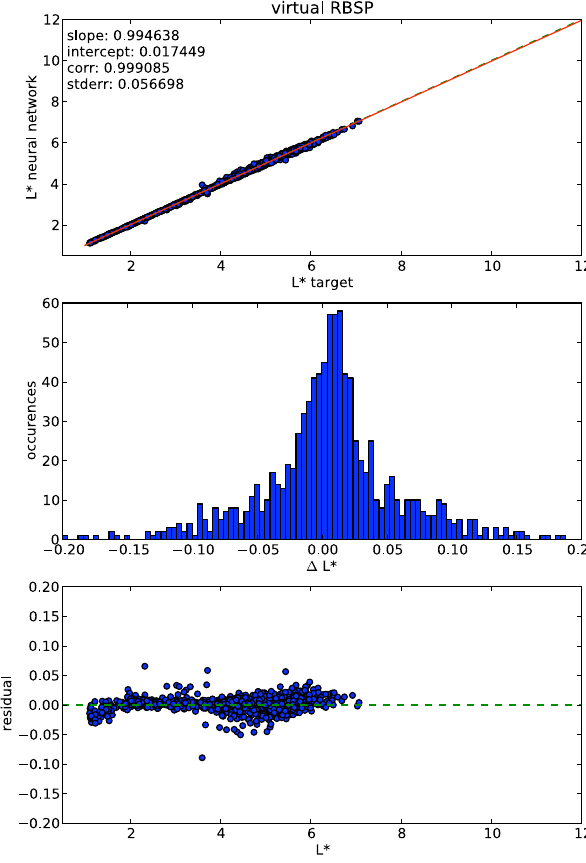
Fig. 4. Validation of neural network with Polar satellite ephemerides. Top: scatter plot of L ∗ values from TS05 model (tar- get) against neural network results. Green-dashed line indicates a perfect fit and red solid line indicates the least-square fit to the scat- ter plot. One thousand ephemeris points and solar wind conditions were randomly chosen between 1996–2005 covering a wide range of ephemerides due the precession of the spacecraft. Middle: his- togram plot of overall residuals from scatter plot. Bottom: residual plot as a function of L ∗ .